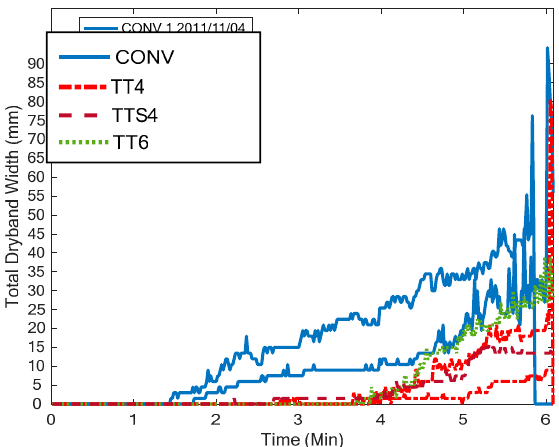
Figure 10. Comparison of the dry-band extension on all the trunks for the five designs, with ESDD = 0.64 mg/cm 2 , and a fog spray rate of 3 L/h.